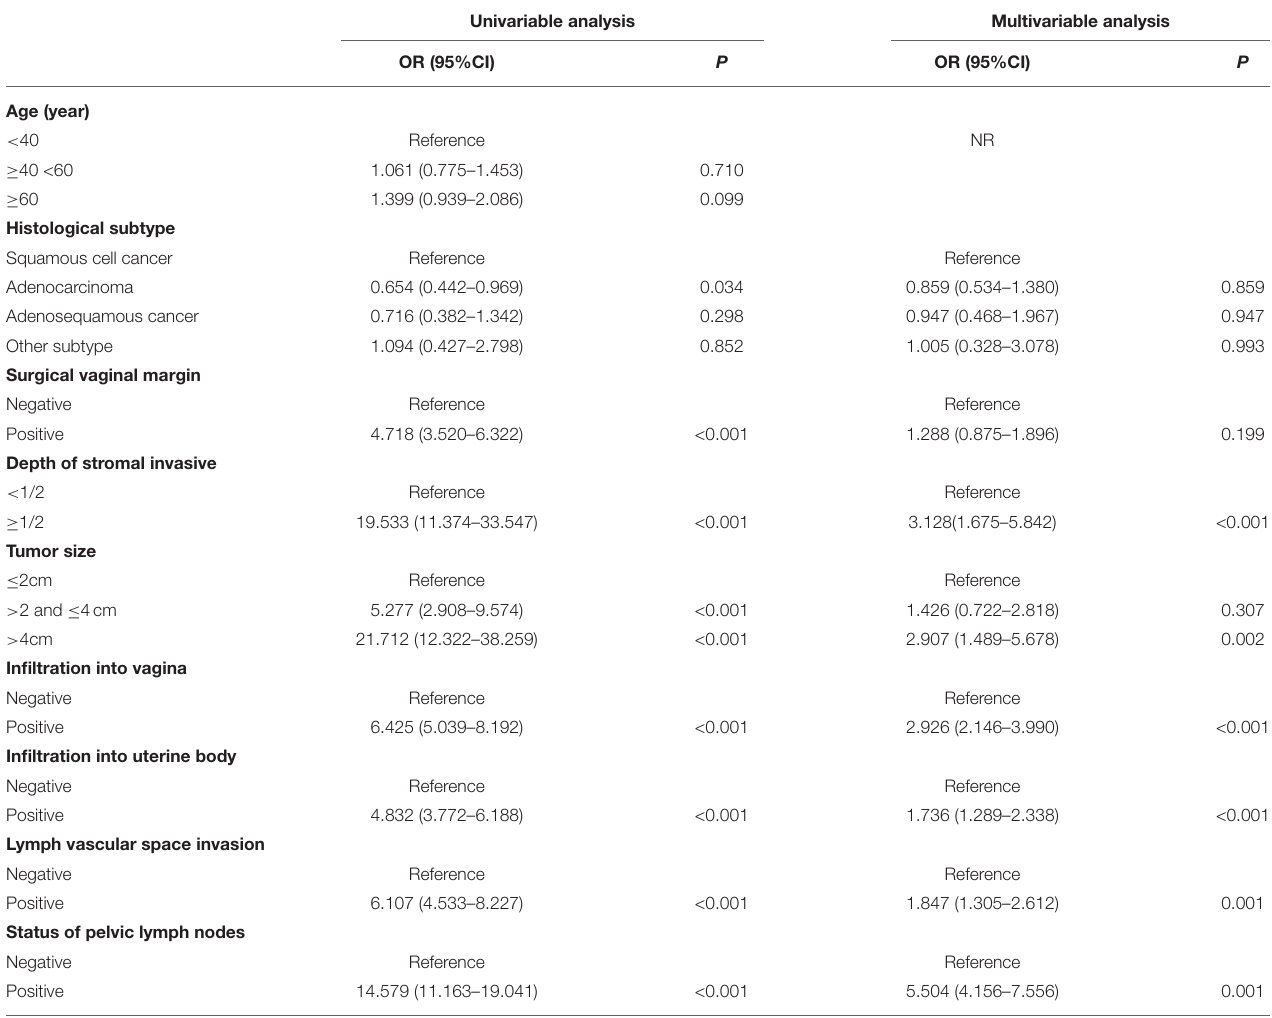
TABLE 4 | The univariable and multivariable Cox regression model analyses of the parametrial invasion in the training